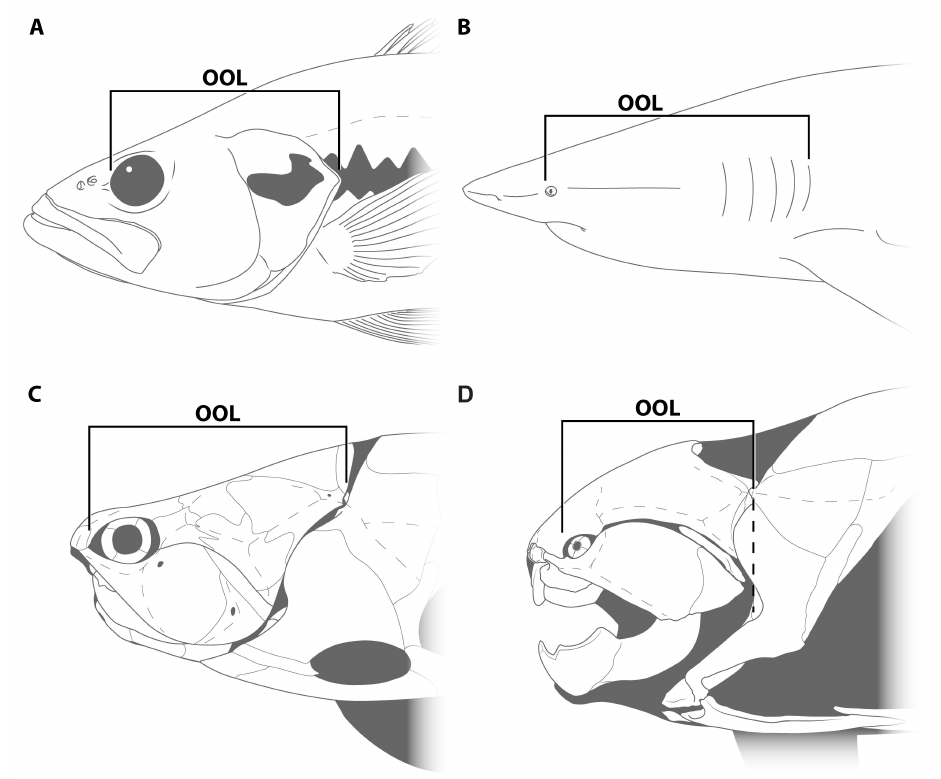
Figure 1. Heads of ( A ), an osteichthyan ( Micropterus dolomieu , CMNH Teaching Collection); ( B ), a chondrichthyan ( Carcharhinus obscurus ; modeled after specimen in [37]); ( C ), a coccosteomorph arthrodire ( Coccosteus cuspidatus , after [15]); and ( D ), Dunkleosteus terrelli (CMNH 6090), showing how orbit-opercular length was measured accounting for different arrangements of the gill skeleton in different lineages. Dotted line in ( C , D ) shows how the cranio–thoracic joint in arthrodires exceeds (in C ) or is equivalent to (in D ) the level of the posterior gill